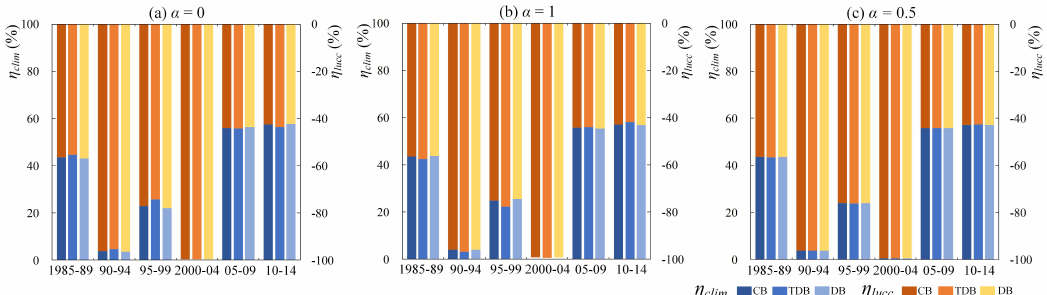
Figure 7. Histograms of the contribution rates of climate change and LUCC (i.e., η clim and η lucc ) for six sub-variation periods based on the baseline period of 1961–1984 calculated by the CB, TDB, and present DB models with ( a ) α = 0 for the lower boundary, ( b ) α = 1 for the upper boundary and ( c ) α = 0.5 in